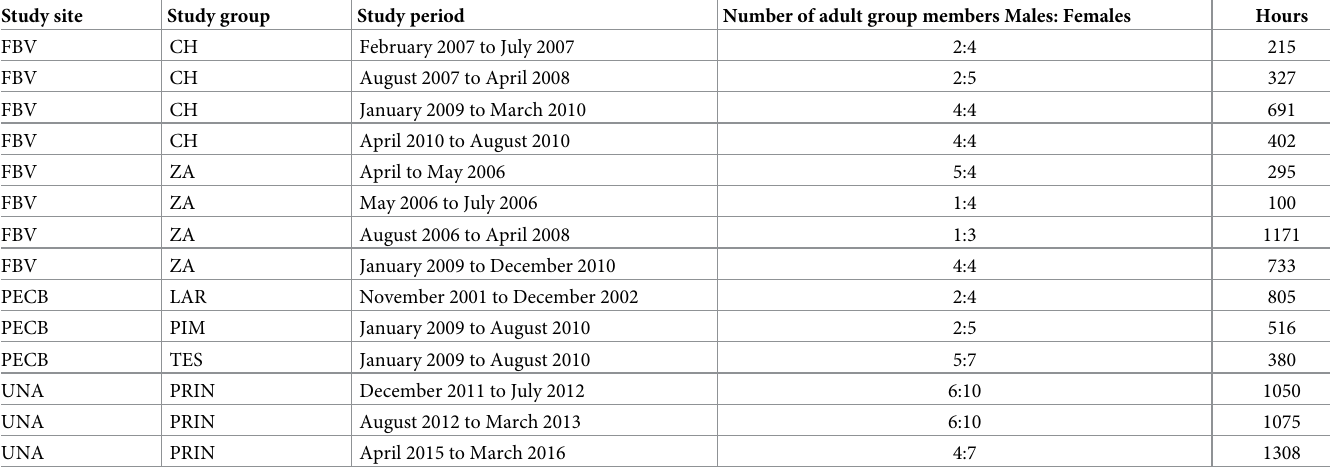
Table 2. Study sites and study groups names, group composition, period of study and total hours of